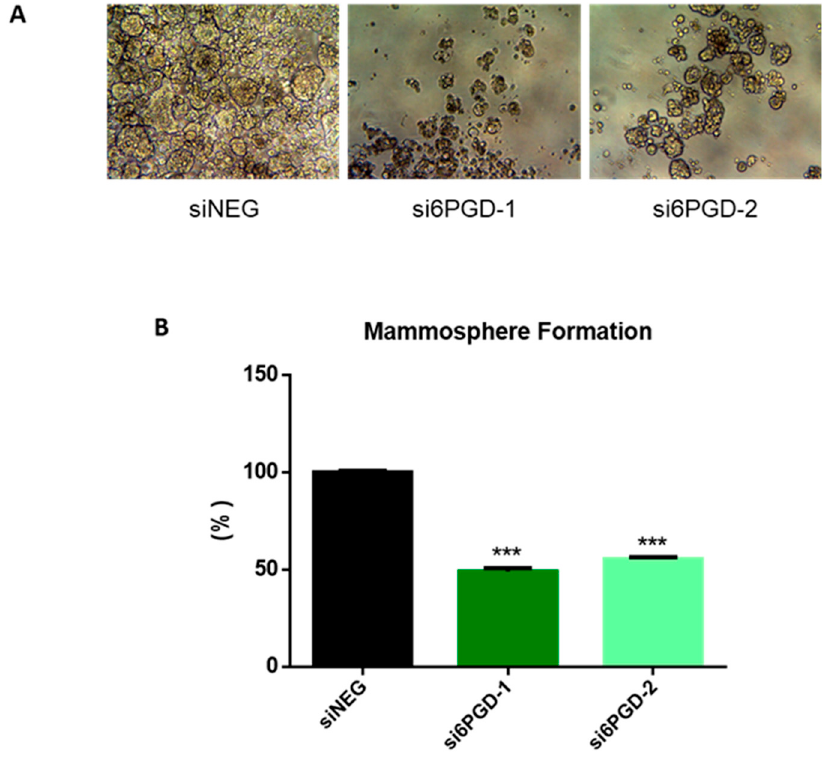
Figure 4. ( A ) Representative photographs showing the different shape, size, and number of mam- mospheres in each experimental condition. ( B ) Mammosphere formation capability of MCF7 cells after treatment with siNEG or si6PGD. The total mammosphere area for each condition was repre- sented as a percentage relative to the total mammosphere surface area of siNEG-transfected cells. Three asterisks (***) denote p -value < 0.001.